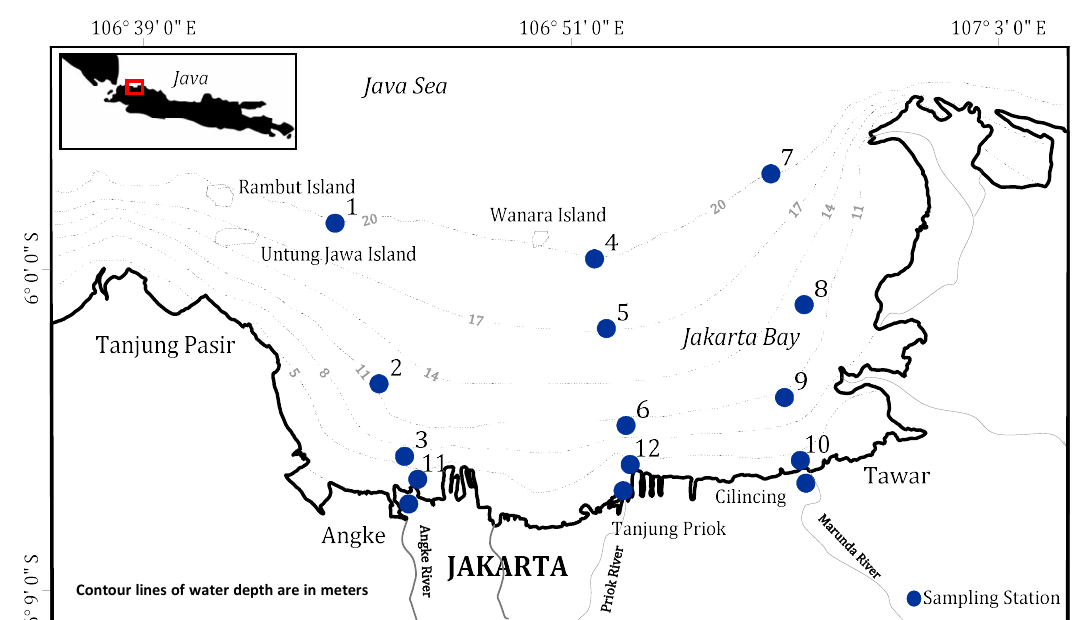
Contour lines of water depth are in meters